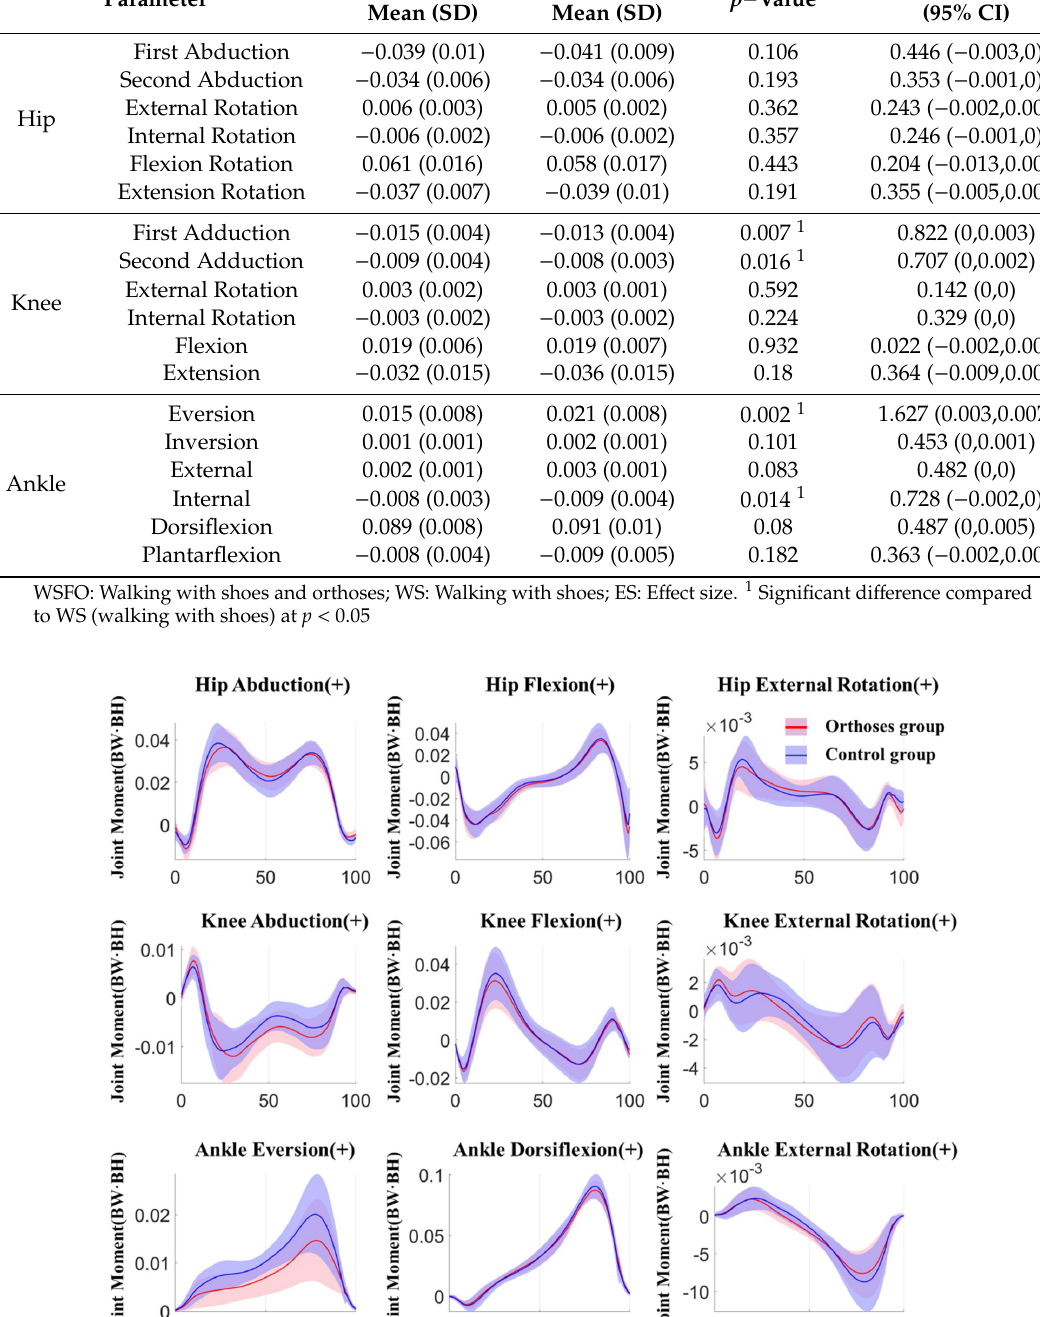
stance phase are listed in Table 3. The lower limb joint contact forces and ground reaction forces Table 2. Peak amplitude of joint moments between two walking conditions during stance (bodyweight versus time during the stance phase between WSFO and WS (control) are compared in Figure 6. times the body height, BW · BH). Table 2. Peak amplitude of joint moments between two walking conditions during stance (bodyweight times the body height, BW·BH).